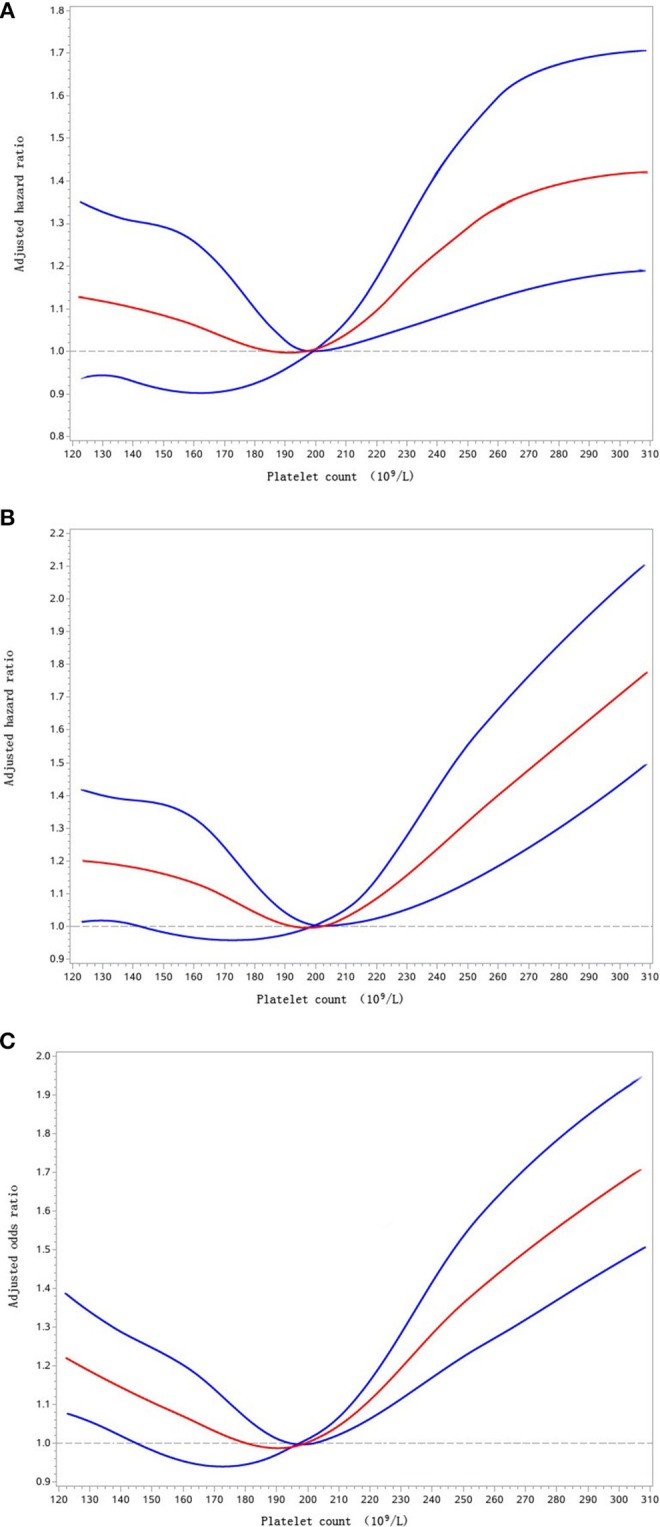
Adjusted hazard ratios of recurrent stroke (A), all-cause mortality (B), and adjusted odds ratio of poor functional outcome (C) according to platelet count. Red lines indicate adjusted hazard/odds ratio, and blue lines indicate the 95% confidence interval bands. Reference is platelet count of 199 × 109/L. Data were fitted with a Cox regression model of restricted cubic spline with 5 knots (5th, 25th, 50th, 75th, and 95th percentiles) for platelet count, with adjustment for potential covariates. The lowest 5% and highest 5% of participants are not shown for small sample sizes.